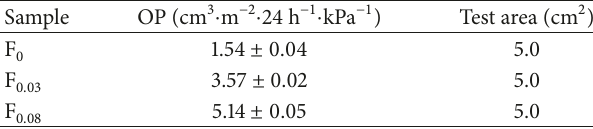
Table 4: The OP values of composite films (F 0 , F 0.03 , and F 0.08